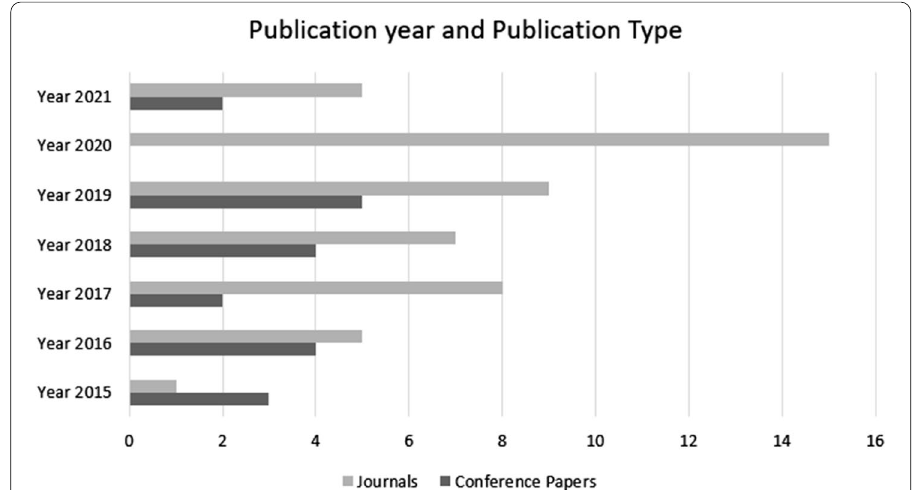
Fig. 2 Distribution of publications by year and publication type